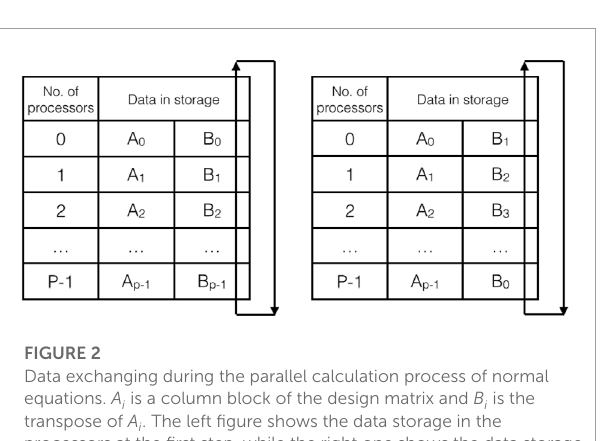
FIGURE 2 Data exchanging during the parallel calculation process of normal equations. A i is a column block of the design matrix and B i is the transpose of A i . The left figure shows the data storage in the processors at the first step, while the right one shows the data storage exchange after finishing the first step in the loops.